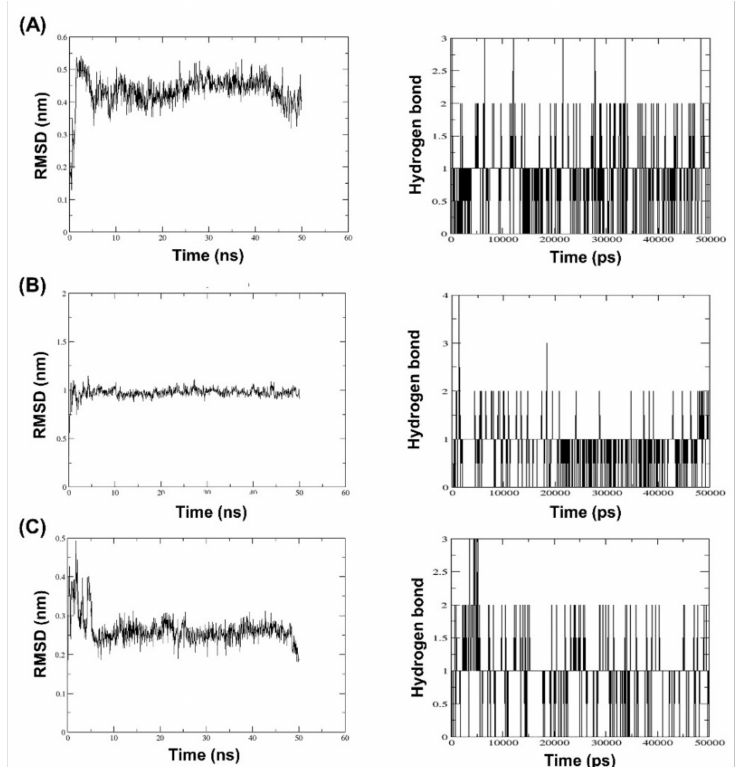
Figure 4. Molecular dynamics simulation of beta-tubulin with ( A ) alpha-mangostin, ( B ) 1,6- dihydroxy-7-methoxy-2,8-bis(3-methylbut-2-en-1-yl)-9H-xanthen-9-one, and ( C ) 1,6-dihydroxy-2,8-